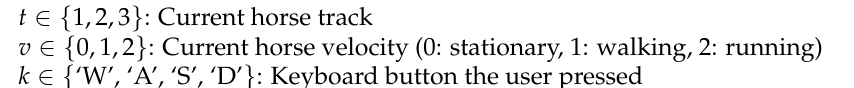
Algorithm 1 The update ( t , v ) function for the user’s keyboard input.